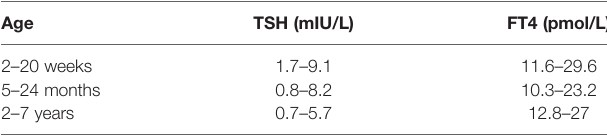
TABLE 1 | Reference ranges in the treatment of patients with congenital hypothyroidism